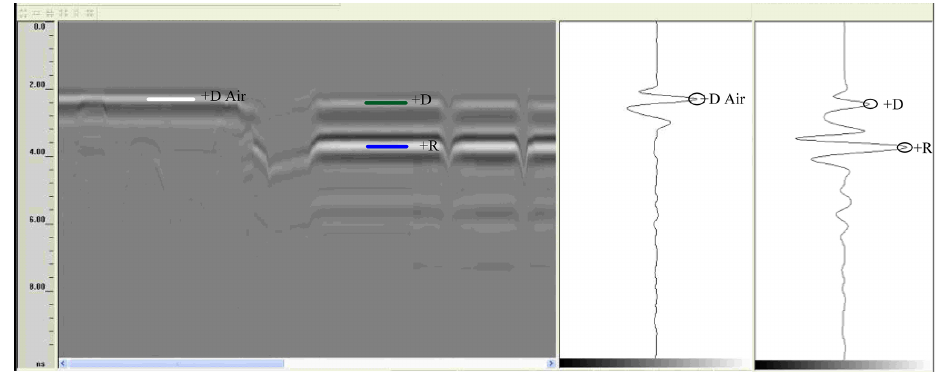
Figure 4. B-scans showing the direct-air, direct and reflected waves measured over the sample when the polarisation of the electric field was perpendicular to the fibres and at a 12% humidity level by mass